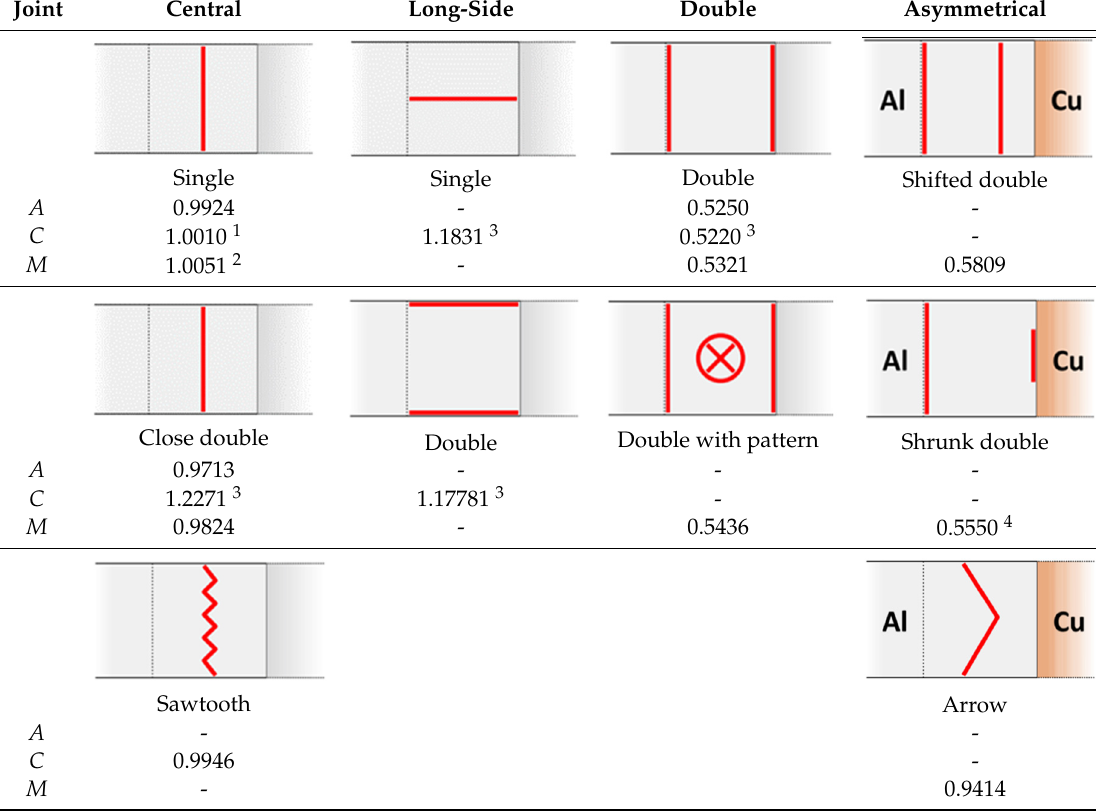
Hypothesis: Higher thermal impact a ff ected material deformations and hence elevated frictional contact resistances. resistances. Hypothesis: Higher thermal impact affected material deformations and hence elevated resistances. Hypothesis: Higher thermal impact affected material deformations and hence elevated 4 Values after correction for inhomogeneous current flow. Raw measurements show higher resistance for single and resistances. Hypothesis: Higher thermal impact affected material deformations and hence elevated lower resistance for double long-side resistances. Hypothesis: Higher thermal impact affected material deformations and hence elevated resistances. Hypothesis: Higher thermal impact affected material deformations and hence elevated frictional contact resistances . 4 Values after correction for inhomogeneous current flow. Raw frictional contact resistances . 4 Values after correction for inhomogeneous current flow. Raw resistances. Hypothesis: Higher thermal impact affected material deformations and hence elevated resistances. Hypothesis: Higher thermal impact affected material deformations and hence elevated resistances. Hypothesis: Higher thermal impact affected material deformations and hence elevated resistances. Hypothesis: Higher thermal impact affected material deformations and hence elevated frictional contact resistances . 4 Values after correction for inhomogeneous current flow. Raw frictional contact resistances . 4 Values after correction for inhomogeneous current flow. Raw frictional contact resistances . 4 Values after correction for inhomogeneous current flow. Raw frictional contact resistances . 4 Values after correction for inhomogeneous current flow. Raw measurements show higher resistance for single and lower resistance for double long-side welds. measurements show higher resistance for single and lower resistance for double long-side welds. frictional contact resistances . 4 Values after correction for inhomogeneous current flow. Raw frictional contact resistances . 4 Values after correction for inhomogeneous current flow. Raw frictional contact resistances . 4 Values after correction for inhomogeneous current flow. Raw measurements show higher resistance for single and lower resistance for double long-side welds. frictional contact resistances . 4 Values after correction for inhomogeneous current flow. Raw measurements show higher resistance for single and lower resistance for double long-side welds. measurements show higher resistance for single and lower resistance for double long-side welds. measurements show higher resistance for single and lower resistance for double long-side welds.